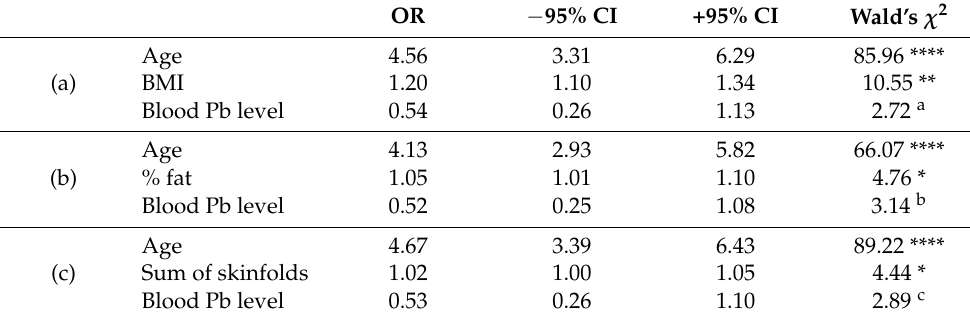
Table 3. Results of three logistic regression models with menarcheal status (no = 0, yes = 1) as the dependent variable and age, blood lead level (binary variable: low and high), BMI (a), %fat (b) and sum of skinfolds (c) as independent